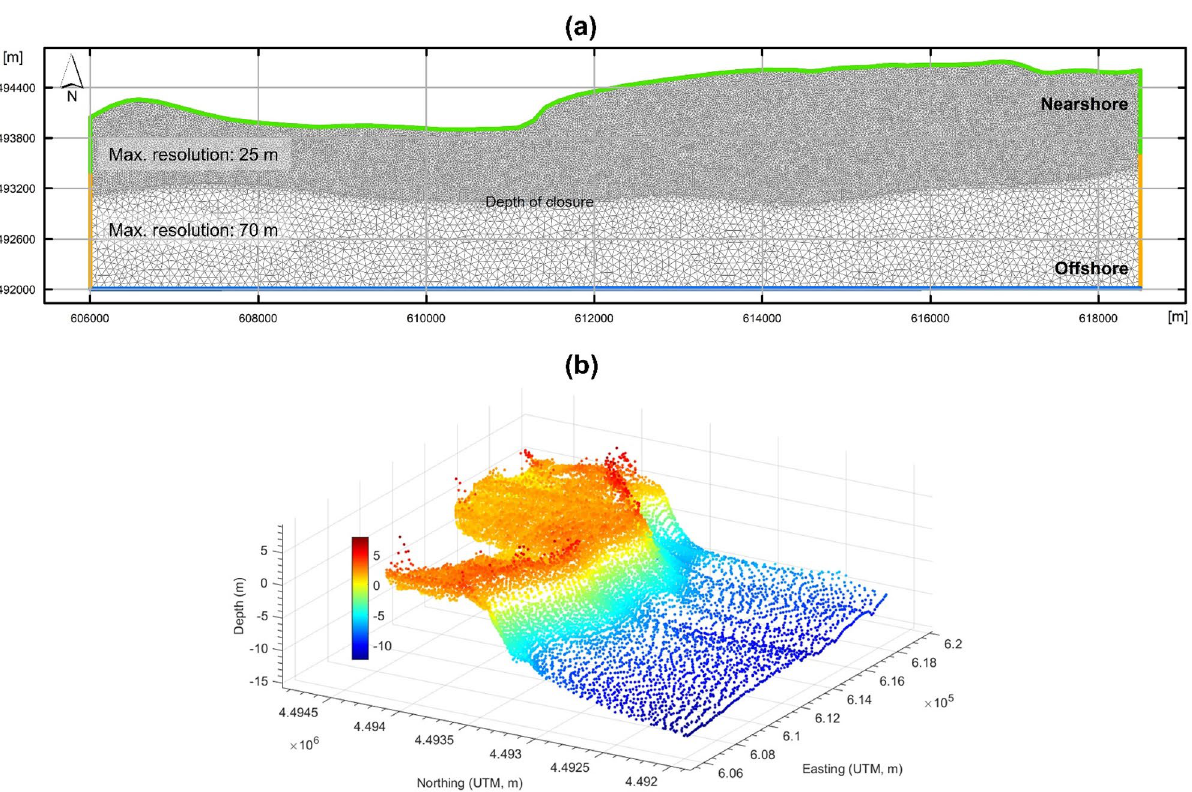
Figure 5. Computational mesh used for shoreline evolution simulations. ( a ) Finite volume mesh generated. ( b ) Mesh nodes interpolated with topography and bathymetry data from the 2014 DEM